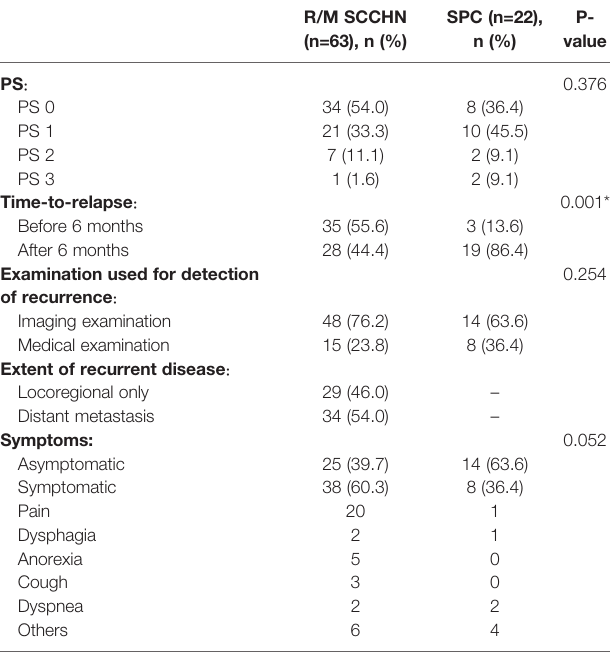
TABLE 2 | Characteristics of R/M SCCHN and SPC at the detection of